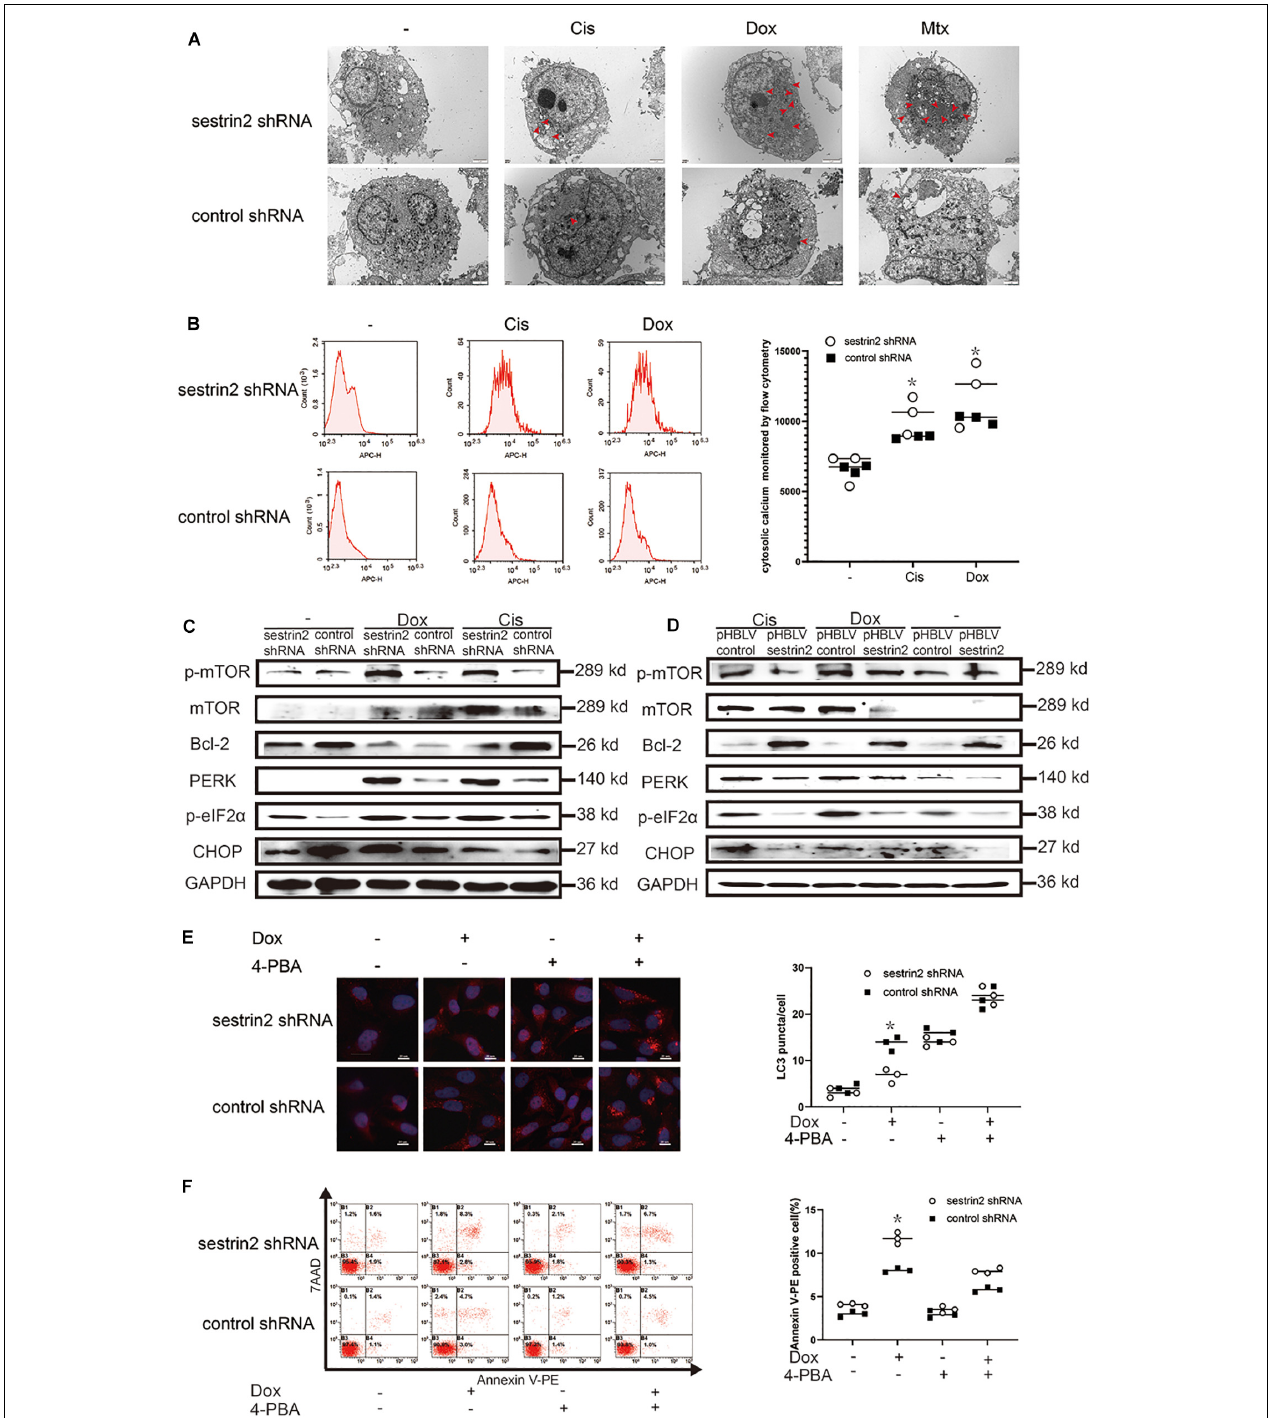
FIGURE 5 | SESN2 promotes autophagy and inhibits apoptosis through endoplasmic reticulum (ER) stress. After cells were treated with Cis (20 µ mol/L), Dox (0.2 µ g/mL), or Mtx (50 µ mol/L) for 24 h, ER stress in SESN2-knockdown HOS cells was observed by TEM (A) ( n = 3, scale bar = 2 µ m). After cells were treated with Cis (20 µ mol/L) and Dox (0.2 µ g/mL) for 24 h, intracellular calcium in SESN2-knockdown and control HOS cells was monitored by flow cytometry (B) ( n = 3). The protein expression levels of genes involved in apoptosis-, autophagy- and ER stress-related pathways in HOS cells with upregulated and downregulated SESN2 expression were detected by western blot (C,D) ( n = 3). Twenty-four hours after Dox (0.2 µ g/mL) treatment, the LC3 puncta in HOS cells from the SESN2-knockdown group and the control group were detected by immunofluorescence, and apoptosis was analysed by flow cytometry in the presence and absence of 4-PBA (5 mM) (E,F) ( n = 3, scale bar = 20 µ m). The data are presented as the mean ± SD. * p < 0.05 vs. the Control shRNA group.